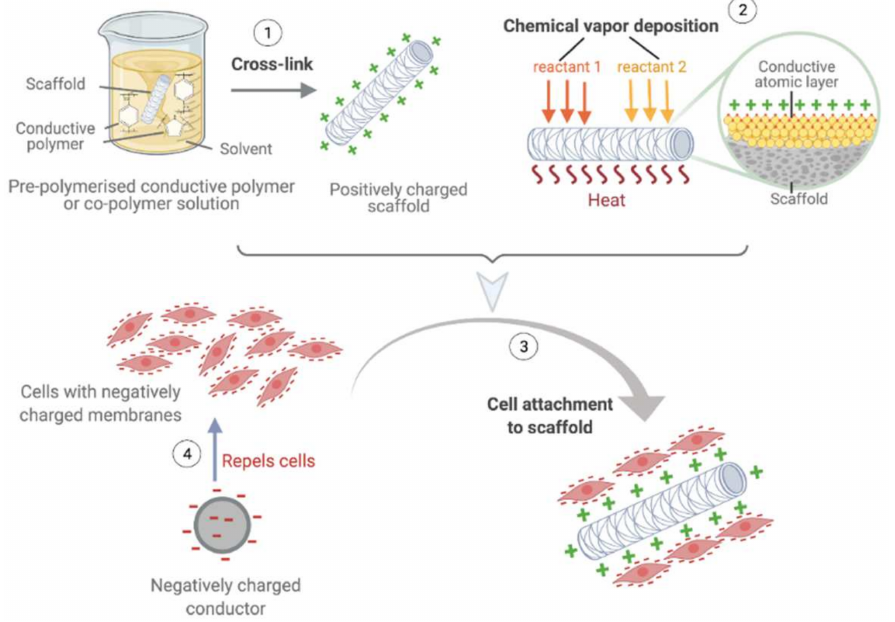
Figure 7. Electrostatic seeding. Scaffolds are manipulated to become positively charged substrates to attract the negatively charged regions on cell membranes for increased retention and attachment of cells. Scaffolds can be chemically modified by either cross-linking polymers in pre-polymerised solutions during the fabrication process (1), or by covering scaffold surfaces with a thin conductive layer via atomic layer deposition post-fabrication (2). The negatively charged cells can then be seeded on to the positively charged scaffold (3). Negatively charged conductors can also be employed to repel cells to increase the efficiency of cell attachment on scaffolds. (Created with BioRender.com, accessed on 8 January